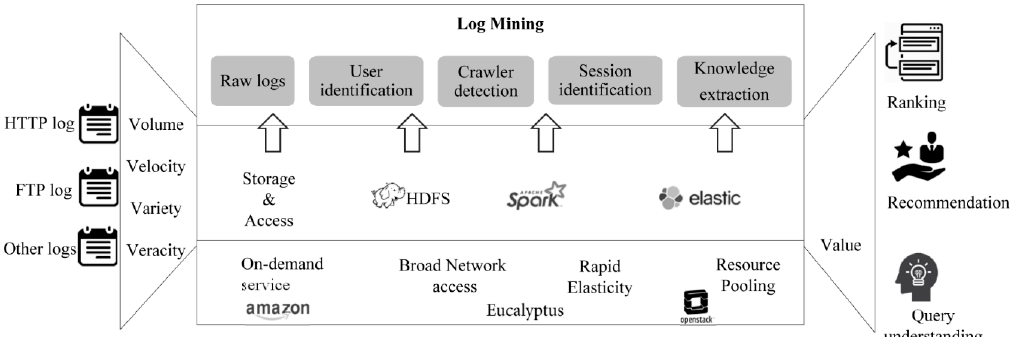
Figure 4. The framework for log mining.